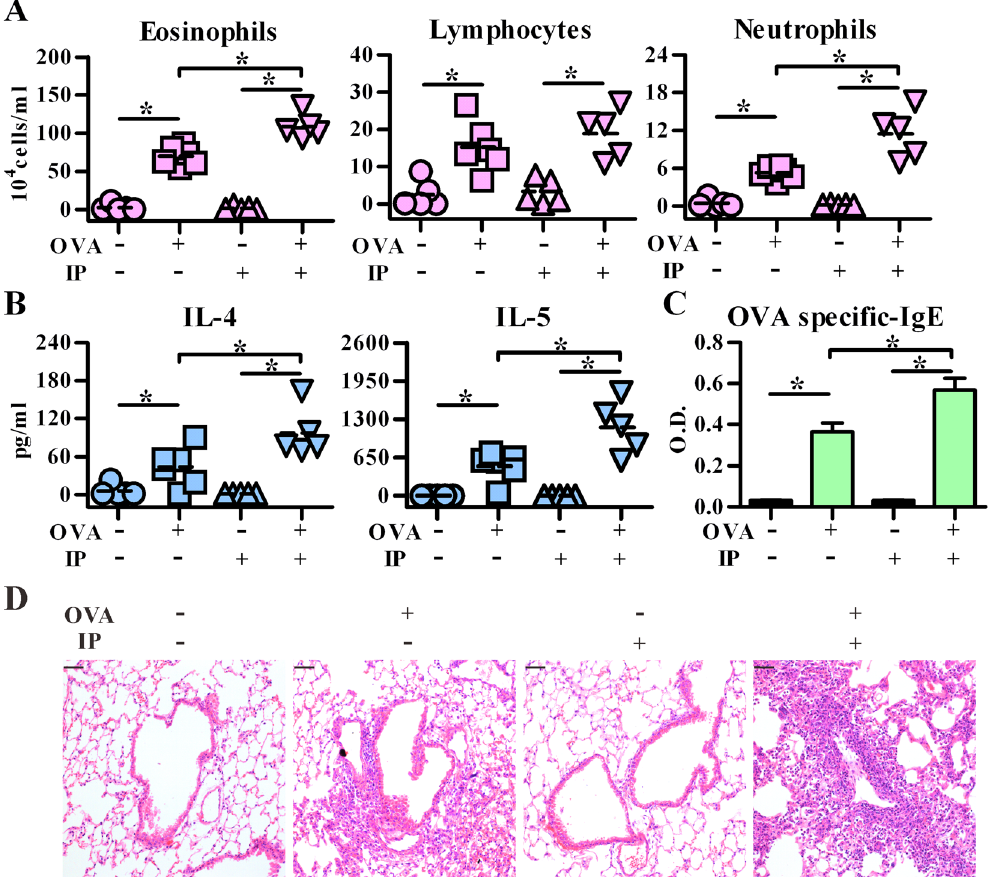
Figure 3. Indeno[1,2,3-cd]pyrene (IP) exposure aggravates the severity of allergic lung inflammation in the presence of allergen. C57BL/6 mice intranasally pre-exposed to vehicle or IP (2 μ M) were then immunized either with PBS or OVA as indicated. All mice were then challenged with OVA aerosol for three consecutive days. Cell subsets ( A ) and cytokine levels ( B ) in BALFs were both determined by flow cytometry. The line within the vertical points marks the mean for each group. ( C ) Serum levels of OVA-specific IgE Abs (mean ± SEM) were measured by ELISA. ( D ) Representative lung sections stained with hematoxylin and eosin. The magnification: 200 × . Data represent one of five independent experiments with consistent results. * P < 0.05 (Mann-Whitney U test). Scale bars represent 50 µ m in ( D